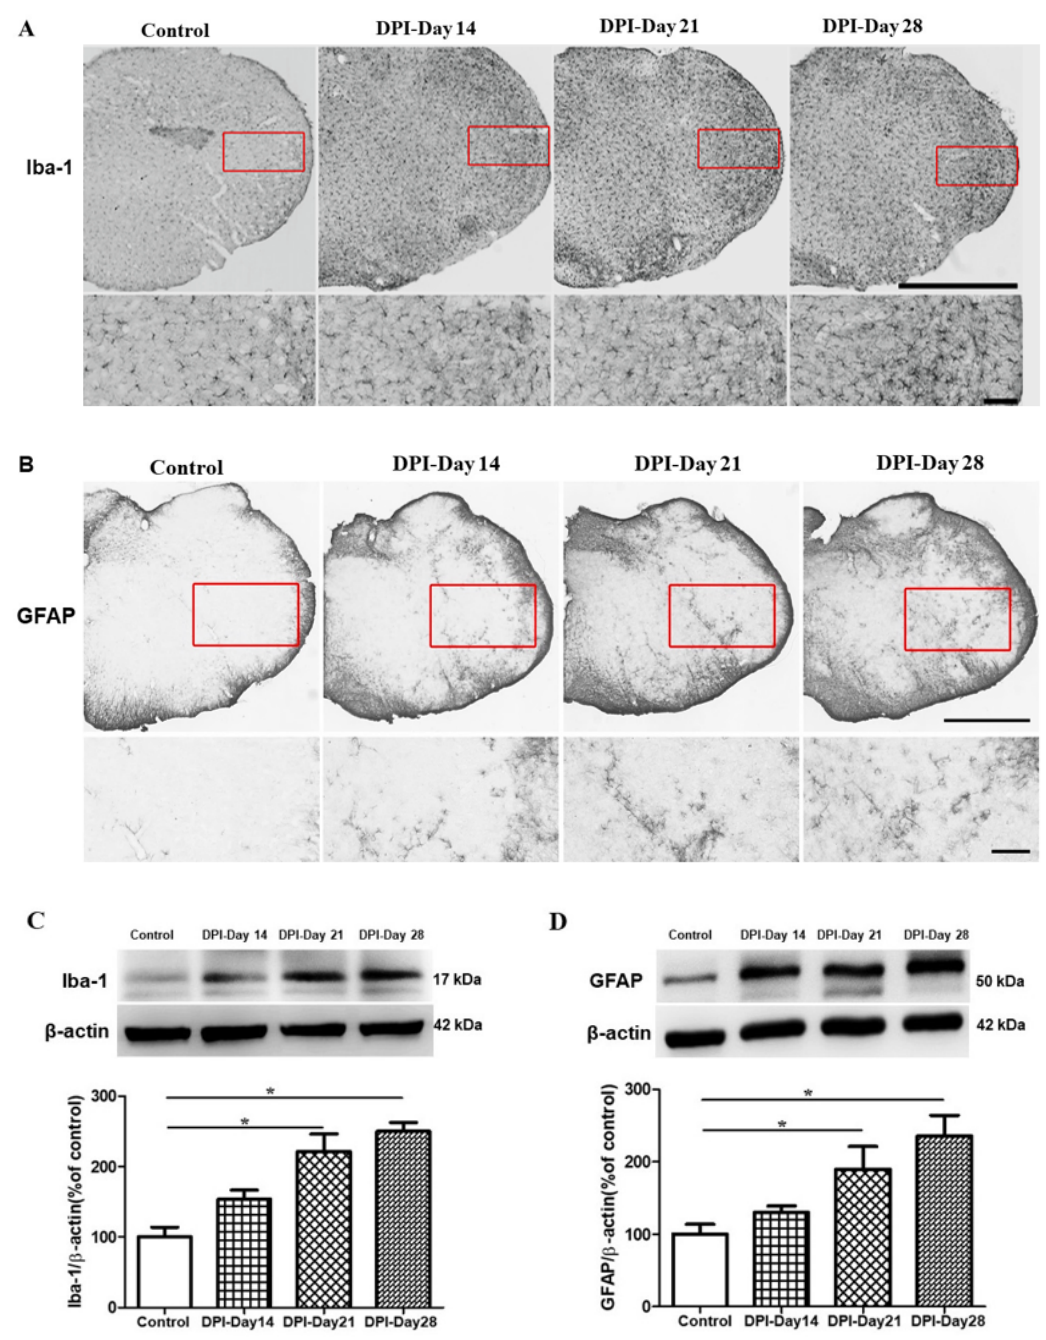
Figure 3. Microglial and astrocytes activation on Day 21 and persisted through Day 28 after DPI. ( A , B ) Representative photomicrographs of Iba-1 and GFAP expression respectively, in 4 groups of mice: controls, DPI-Day 14, DPI-Day 21 and DPI-Day 28. ( C , D ) Western blot analysis revealed no significant differences in Iba-1 and GFAP protein levels between the DPI-Day 14 group and controls, whereas Iba-1 and GFAP protein levels were significantly increased on days 21 and 28 when compared with the control group. Histogram showing incremental increases in Iba1 and GFAP levels after DPI. Between-group comparisons for each group were performed by ANOVA, followed by Dunnett’s test (* p < 0.05, versus control group; n = 8 in each group). Scale bars = 1 mm (upper panel), 100 µ m (lower panel) in ( A ) and 1 mm (upper panel), 250 µ m (lower panel) in ( B ).